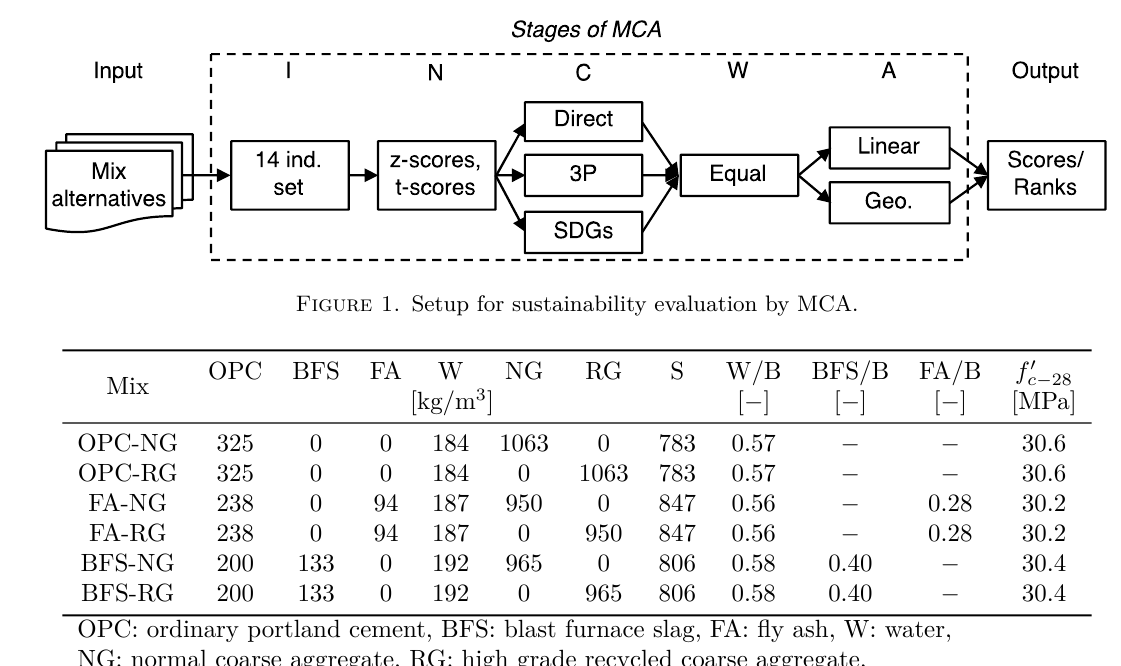
Table 1. Mix proportions and 28-day compressive strengths of the concrete